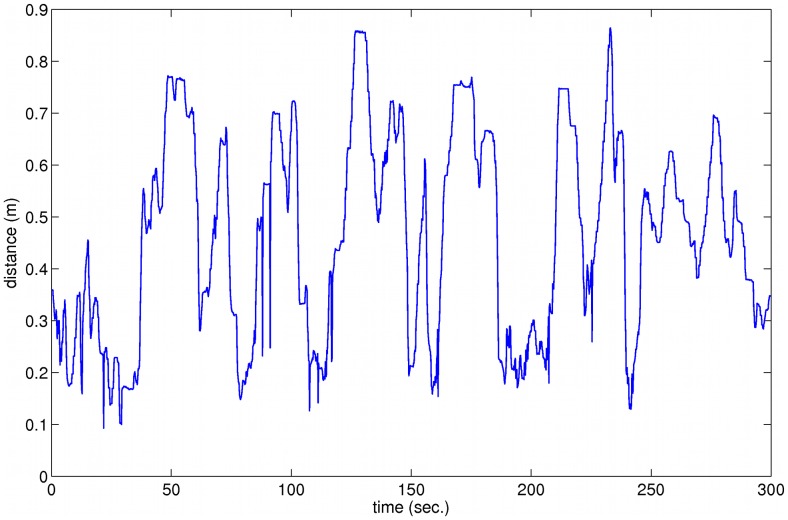
Waveform of distance between Rat A and the robot device for an arbitrary participant.